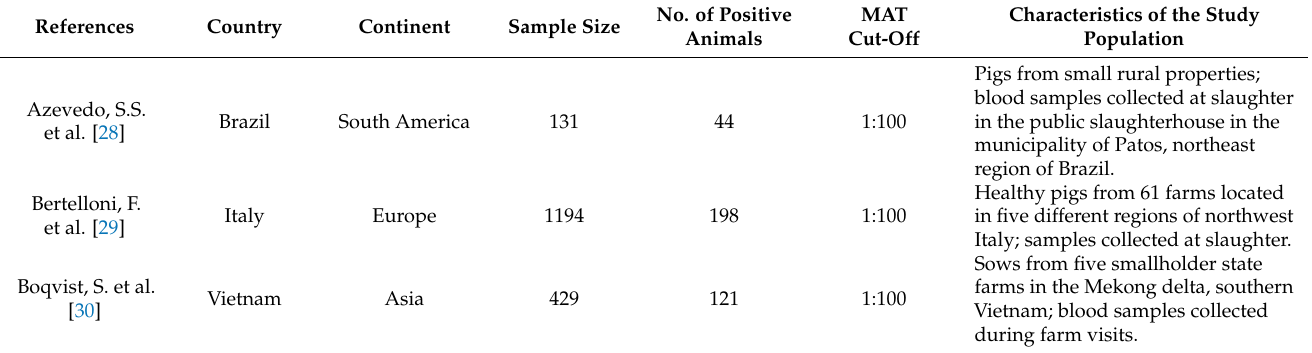
Table 1. Summary of the main characteristics of the 20 studies included in the meta-analysis of seropositivity of swine